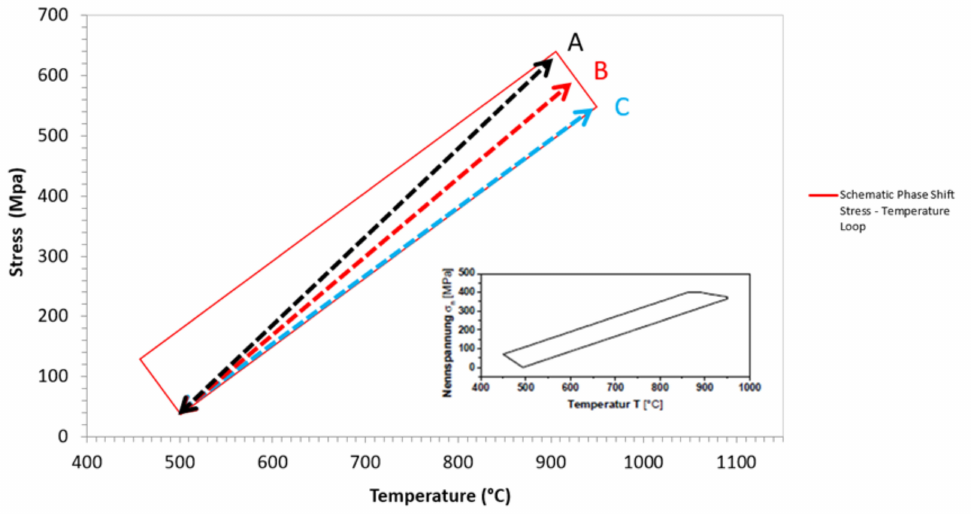
Figure 8. A schematic representation of ∆ σ STAB and the improved ∆ σ calculation used for the <20 ◦ phase shift tests.